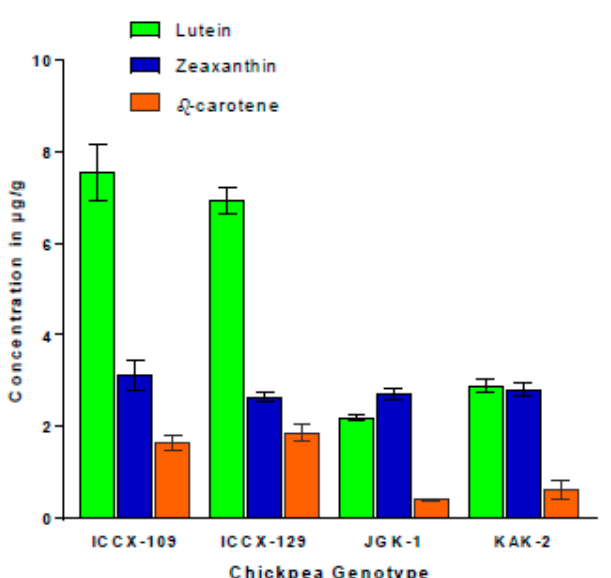
Figure 10. Variation in di ff erent carotenoids content (Lutein, Zeaxanthin and beta carotene) in seeds of stay green chickpea introgression lines (ILs) with di ff erent genetic background [ICCX-109 (KAK2 genetic background and ICCX-129 (JGK1 genetic background) and their recurrent parents (JGK1 and KAK2). The lutein pigment data are represents in light grey colour bars; Zeaxanthin pigment data are represents in black colour bars and beta carotene pigment data are represents in dark grey colour bars. Each data points represents the means ( ± SE) of three replicates per genotype.